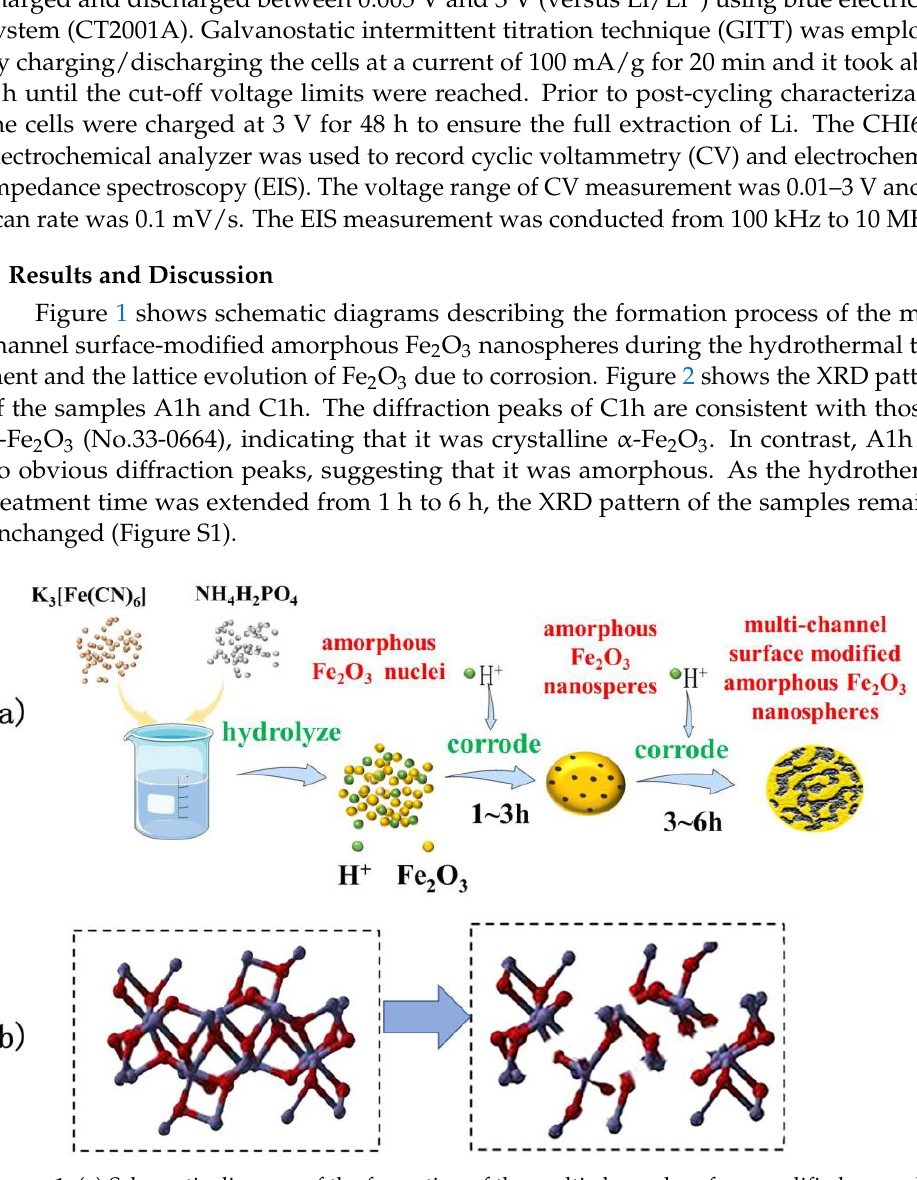
Figure 1. ( a ) Schematic diagram of the formation of the multi-channel surface-modified amorphous Fe 2 O 3 nanospheres during the hydrothermal reaction process. ( b ) Schematic diagram of the evolution of Fe 2 O 3 lattice due to corrosion.